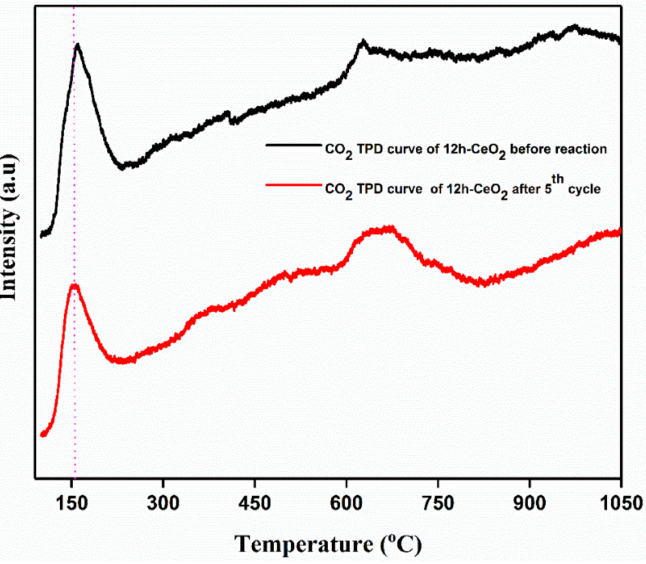
Figure 7. CO 2 TPD curve of CeO 2 testing. The curve represents amount of CO 2